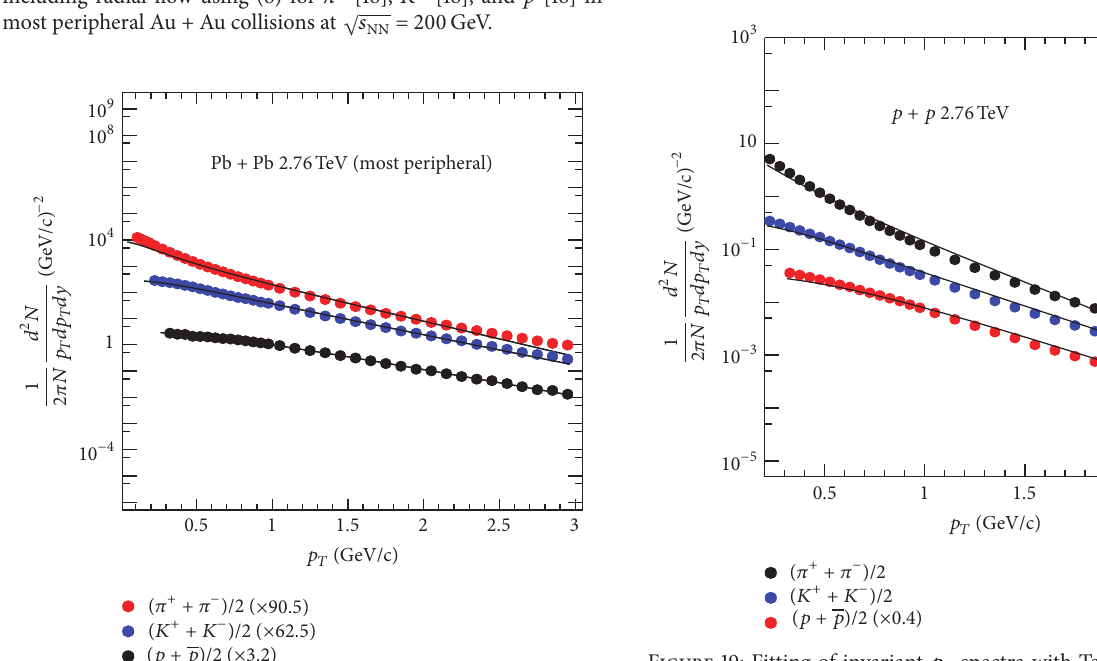
Figure 19: Fitting of invariant 𝑝 𝑇 spectra with Tsallis distribution including radial flow using (8) for (𝜋 + + 𝜋 − )/2 [19, 20], (𝐾 + + 𝐾 − )/2 [19, 20], and (𝑝+𝑝)/2 [19, 20] in 𝑝+𝑝 collisions at √𝑠 NN = 2.76 TeV. Symbols represent the data points and the line is the fit